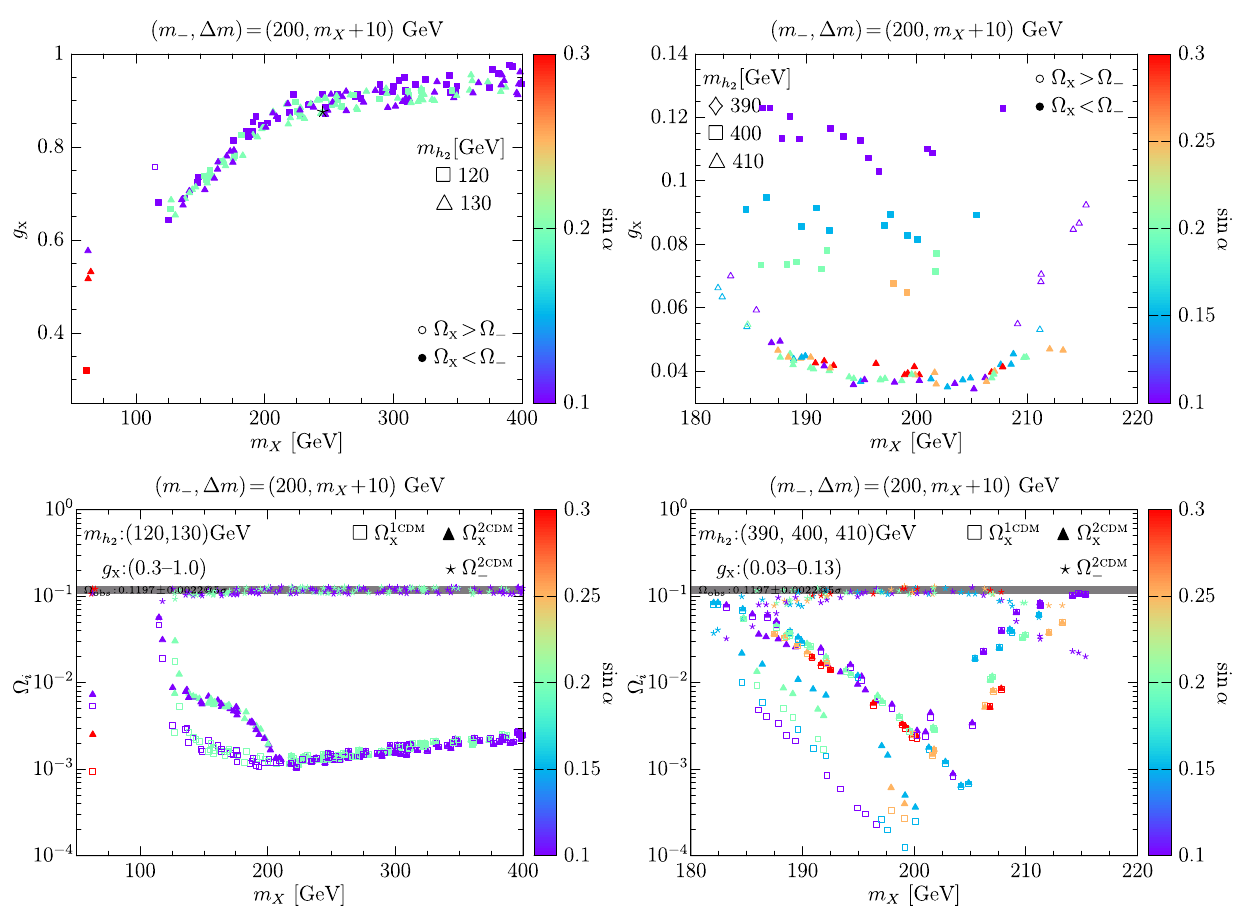
Fig. 6 Upper panels: The plots show results of scans over the parame- ter space of a 2CDM case, where X μ and ψ − are stable. All the points satisfy the correct relic density observed by PLANCK at 5 σ and the recentdirectdetectionexperimentalboundfromLUX2016at2 σ .Lower panels: The plots show results of scans over the parameter space of a 1CDM (assuming the fermions ψ ± are decoupled from the dark sector and hence X μ is the only dark matter particle) and 2CDM (where X μ and ψ − are stable) cases, respectively. In the 2CDM case, all the points